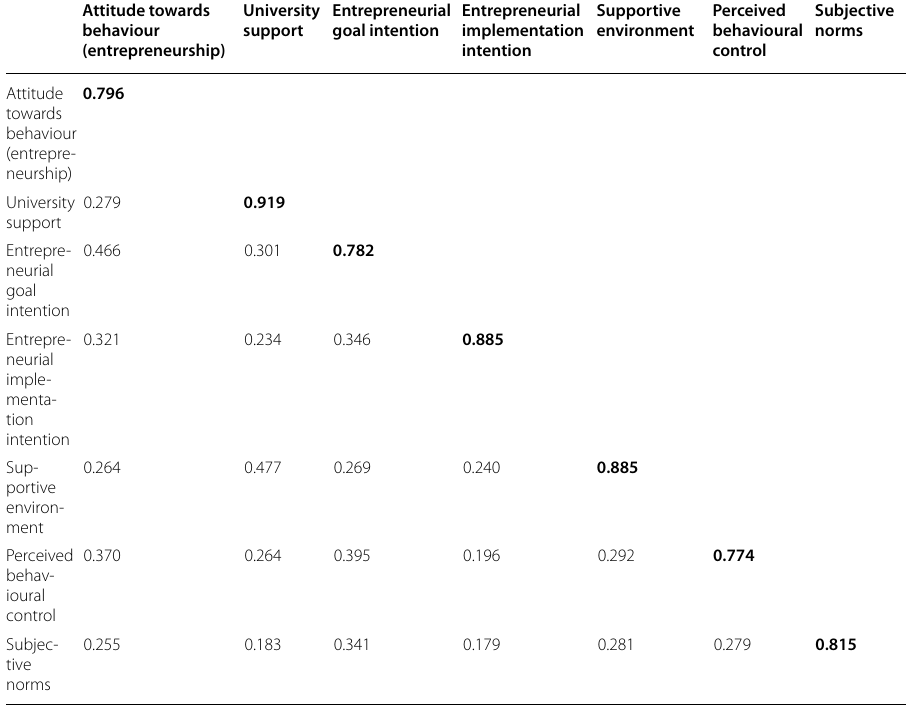
Table 2 Fornell and Larcker